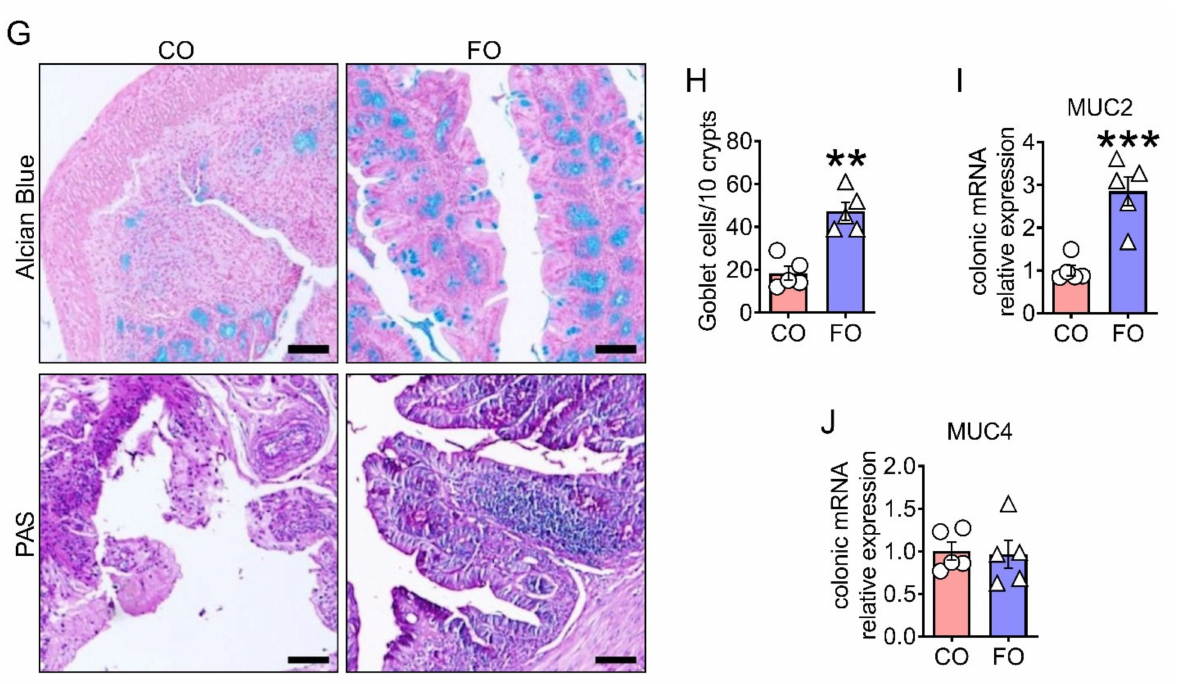
Figure 6. Dietary n-3 PUFA supplementation reduces CPT-11-induced intestinal mucosal barrier dysfunction . ( A ) Gram staining was performed on proximal colonic tissue sections and evaluated by microscopy for the presence of Gram-negative (pink) bacteria (arrowheads). ( B – F ) The markers of colonic mucosal inflammation [toll-like receptor 4 (TLR 4), NF-kB-p65 and TNF- α ], barrier integrity [Zonulin 1 (ZO-1] and infiltration of inflammatory cells were analyzed by real-time polymerase chain reaction (PCR), Bio-Plex immunoassays and Myeloperoxidase (MPO) immunohistochemistry assays to quantify the levels of messenger RNA (mRNA) ( B , C , E ), cytokine ( D ) and infiltrated neu- trophils ( E ), respectively. ( G , H ) Representative pictures showed the differences in colonic Alcian Blue (acid mucins by blue color) and PAS (mixture of acid and neutral mucins by purple color) stained goblet cells and scattered dot-plot showing the numbers of Alcian blue-stained goblet cell counts. ( I , J ) Differences in the Mucin2 (MUC2) and Mucin4 (MUC4) relative gene expression. Data are shown as mean ± standard error of the mean. ** p < 0.01, *** p < 0.001, Student’s t -test or nonparametric Mann–Whitney test. The scale bar for images in ( A , D , G ) panels are 3000 µ m and 1000 µ m,